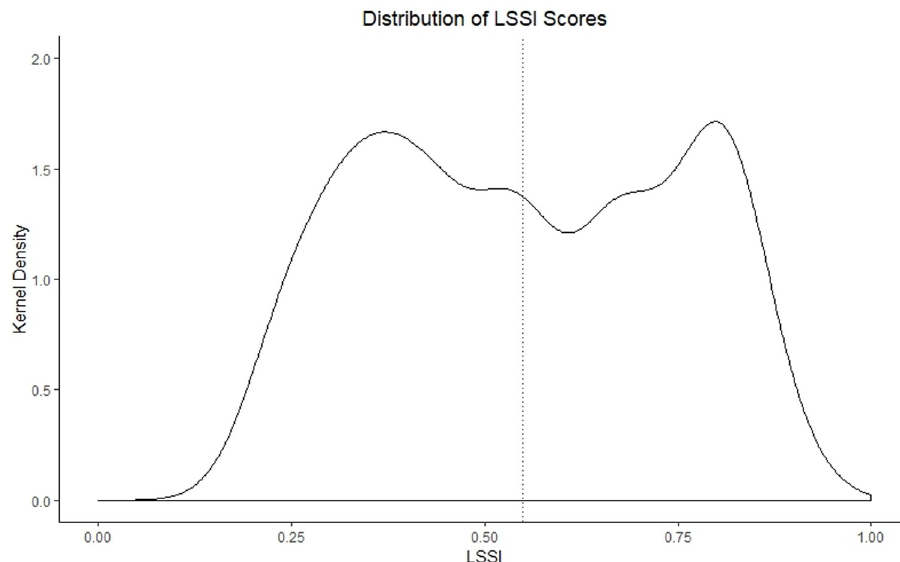
Fig 1. Kernel density plot of complete LSSI